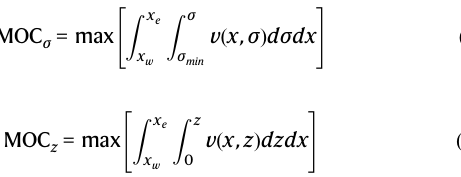
Fig.9|LinkbetweenNordicSeasoverturningandthesubpolarNorthAtlantic. a Simulated and observed 13 overturning streamfunction between2014-2018across the eastern OSNAP (Overturning in the Subpolar North Atlantic Program) section (OSNAP-East). b Time series of maximum overturning strength at OSNAP-East in depth- and density-space from CESM-LE. Solid line shows the mean value and the shading indicates the interquartile spread. c Correlation between trends in max- imum Nordic Seasoverturning strength and trends in the OSNAP-East overturning streamfunction (remapped from density-levels to depth-levels, see main text; ensemblemeandensityvaluesfor2006 – 2100areprovidedforsomedepths)forall 30-year periods between 2006 – 2100 ( n =1980). Solid line shows the mean value